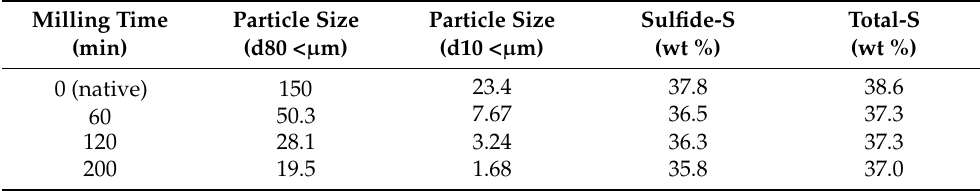
Table 5. Milling time with resulting particle size and sulfur species concentration